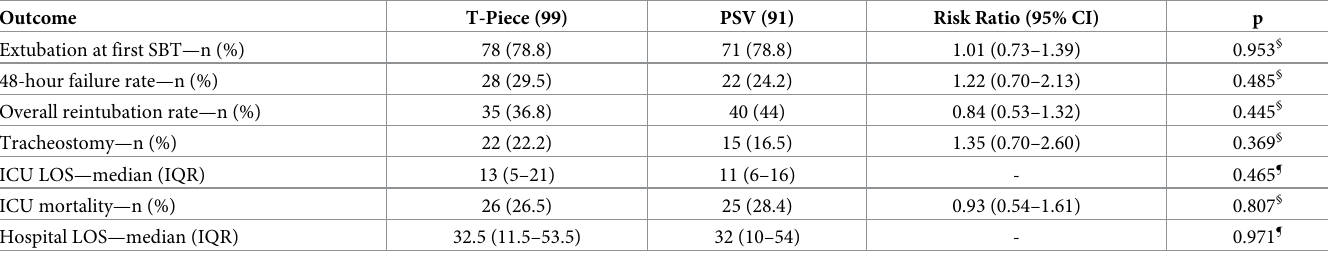
Table 4. Exploratory